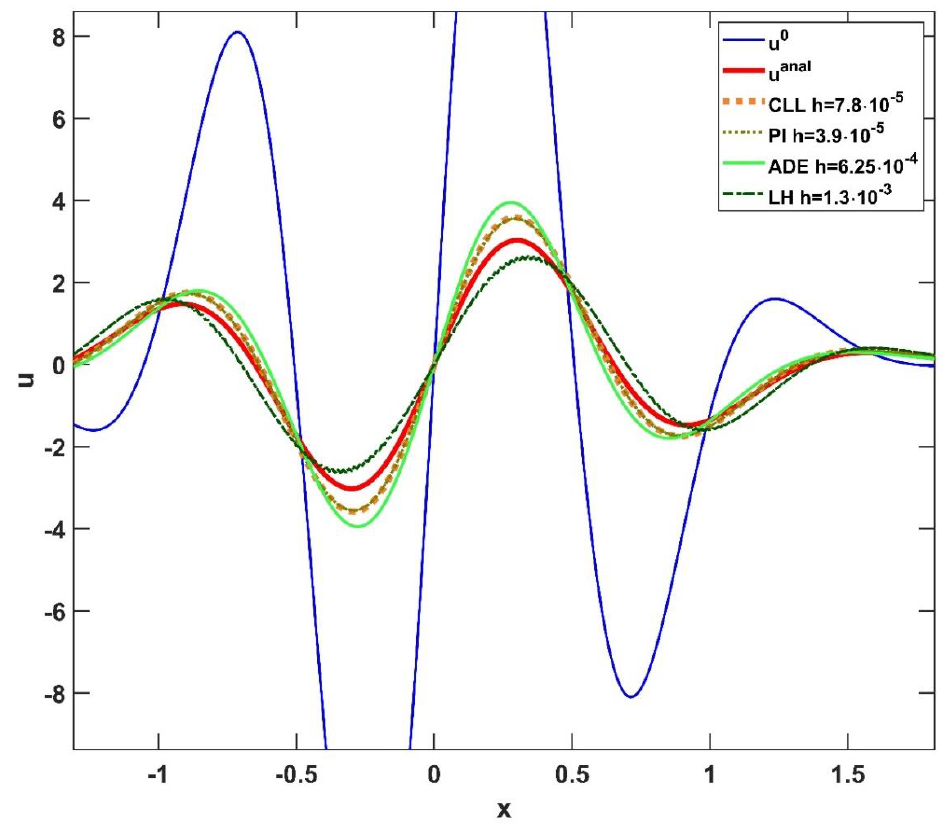
Figure 17. The temperature u as a function of the space coordinate x in Experiment 6. This figure shows the initial temperatures u 0 , the analytical solution u anal and the numerical results, which were obtained with four different methods using different time step sizes.